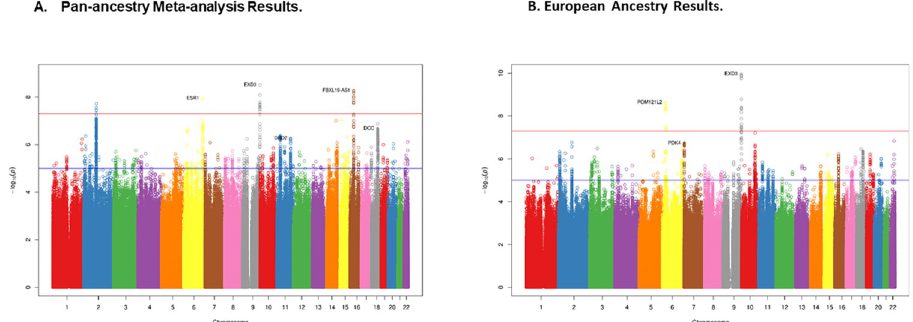
Fig 1. Single Marker GWAS Results for Suicidal Ideation in the Million Veterans Program. A. Pan-ancestry Meta- analysis Results. B. European Ancestry Results.